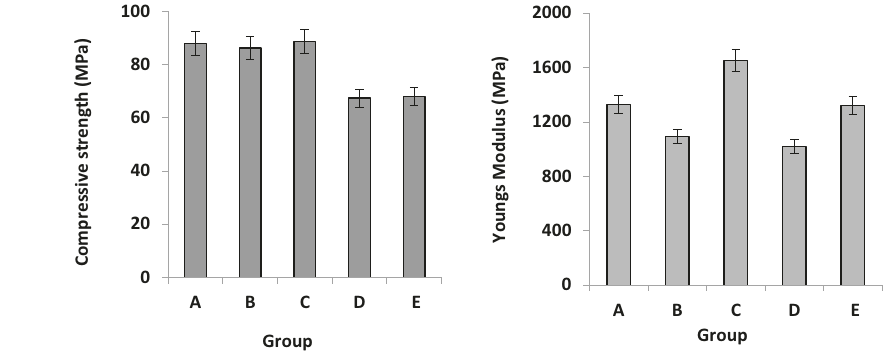
Fig. 5 Compressive Strength (MPa) and Modulus (MPa) Data of group A – E